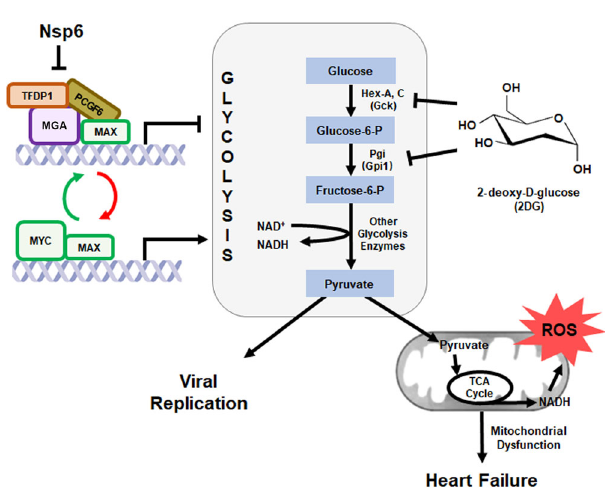
Fig. 7 Model of SARS-CoV-2 Nsp6-mediated disruption of glycolysis. Graphic depiction of proposed model by which SARS-CoV-2 Nsp6 disrupts the MGA/MAX:MYC/MAX balance thereby increasing glycolysis pathway activity, which in turn leads to heart failure and potentially facilitates virus replication. The model also indicates where 2-deoxy-D-glucose (2DG) might intervene and inhibit the Nsp6-glycolysis-induced cardiac phenotype. MGA MAX gene-associated protein, MAX MYC-associated factor X, MYC MYC proto-oncogene, basic helix-loop-helix (BHLH) transcription factor, PCGF6 Polycomb group ring fi nger 6, ROS reactive oxygen species, TCA cycle tricarboxylic acid cycle (a.k.a. Krebs cycle), TFDP1 Transcription factor Dp-1, Hex-A/Hex-C Hexokinase-A/-C, Phosphoglucose isomerase